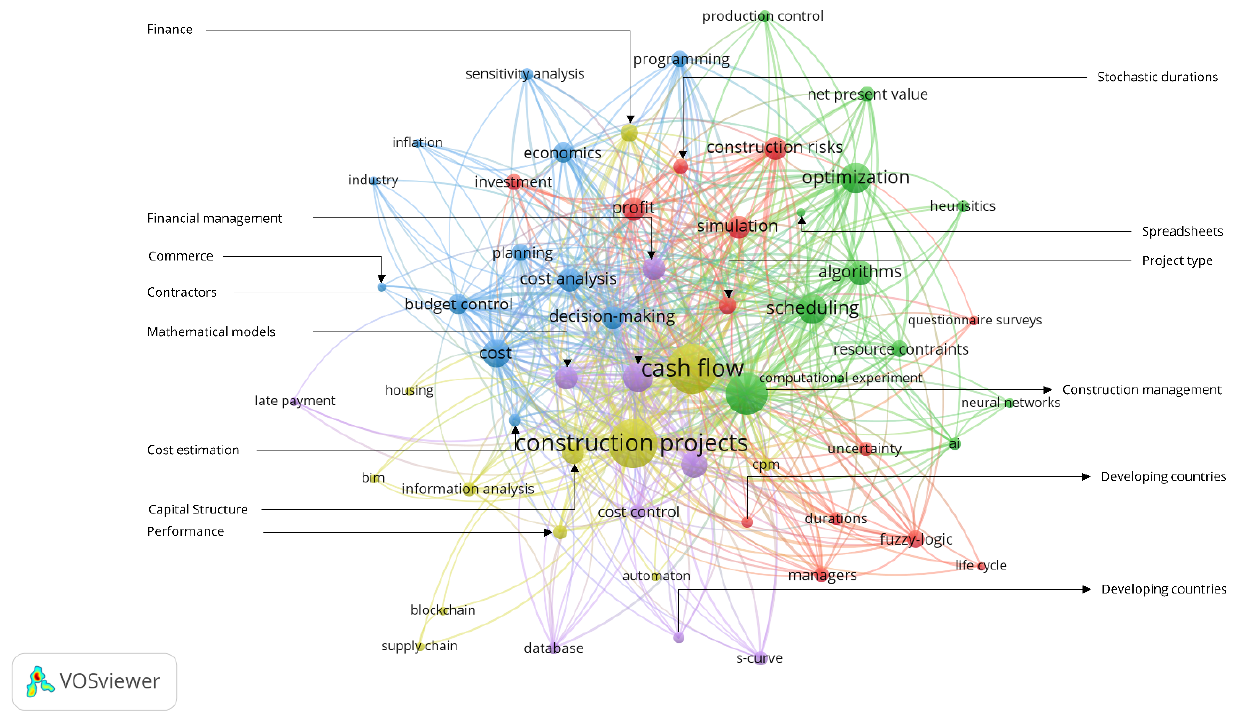
Figure 5. Network visualization map of frequently used keywords in cash flow analysis. Table 2. Top keywords used in the retrieved